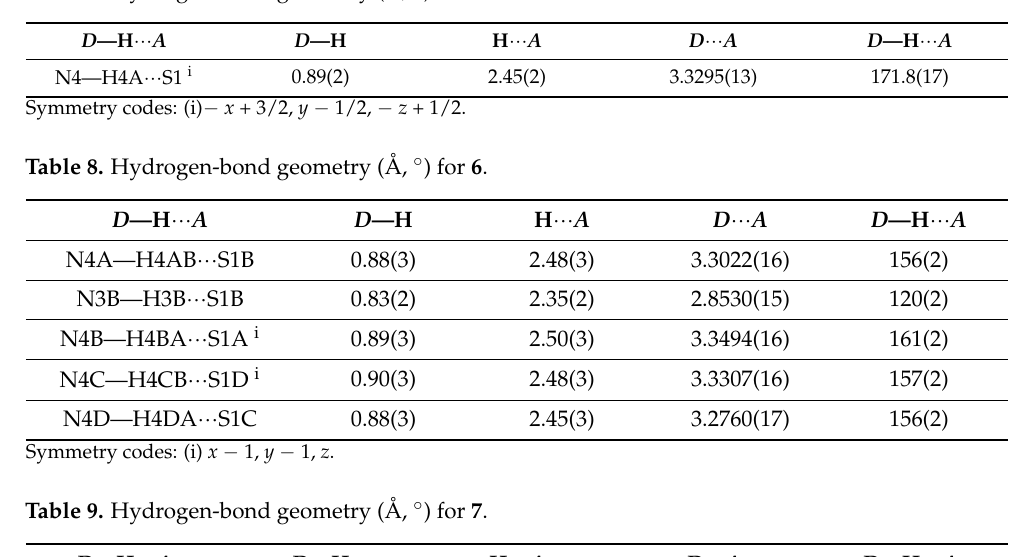
Table 7. Hydrogen-bond geometry (Å, ◦ ) for 5 .